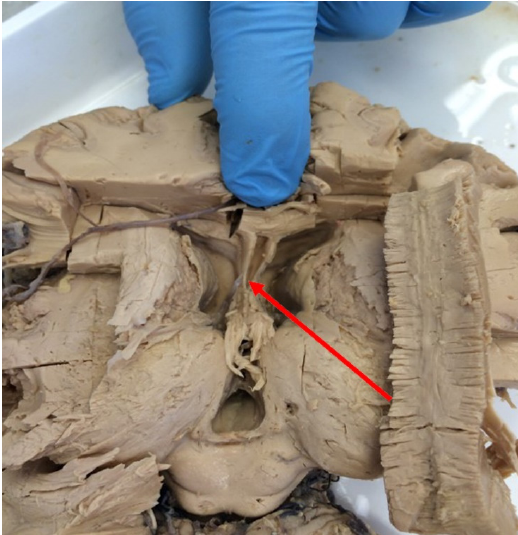
Figure 1. Brain specimen fixed in formaldehyde. Image courtesy of the Department of Descriptive and Clinical Anatomy, Center for Biostructure Research, Medical University of Warsaw. The arrowhead shows separated laminae of the septum pellucidum (preserved cavum septi pellucidi, CSP).